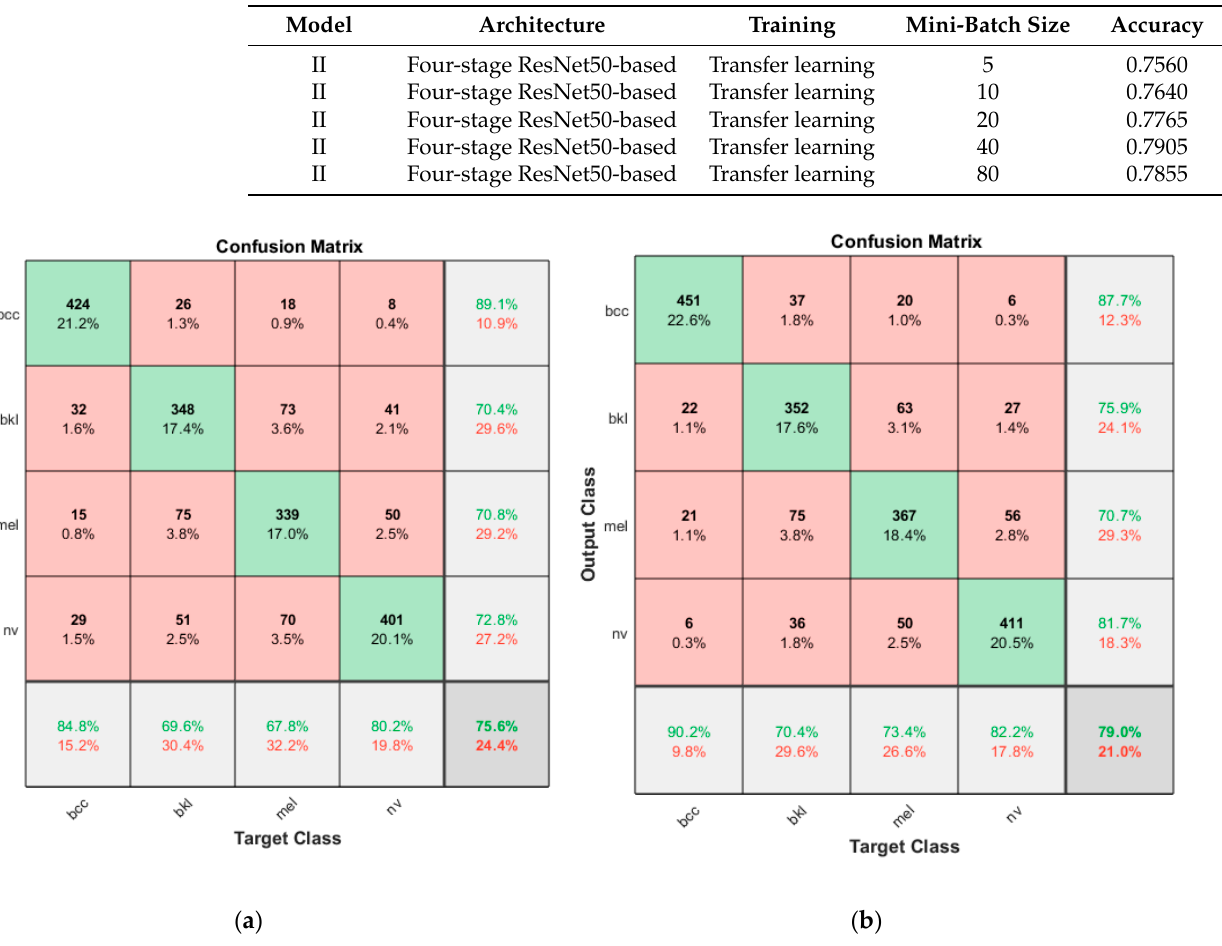
Figure 7. ( a ) Confusion matrix of Model II with a mini-batch size of 5; ( b ) confusion matrix of Model II with a mini-batch size of 40.